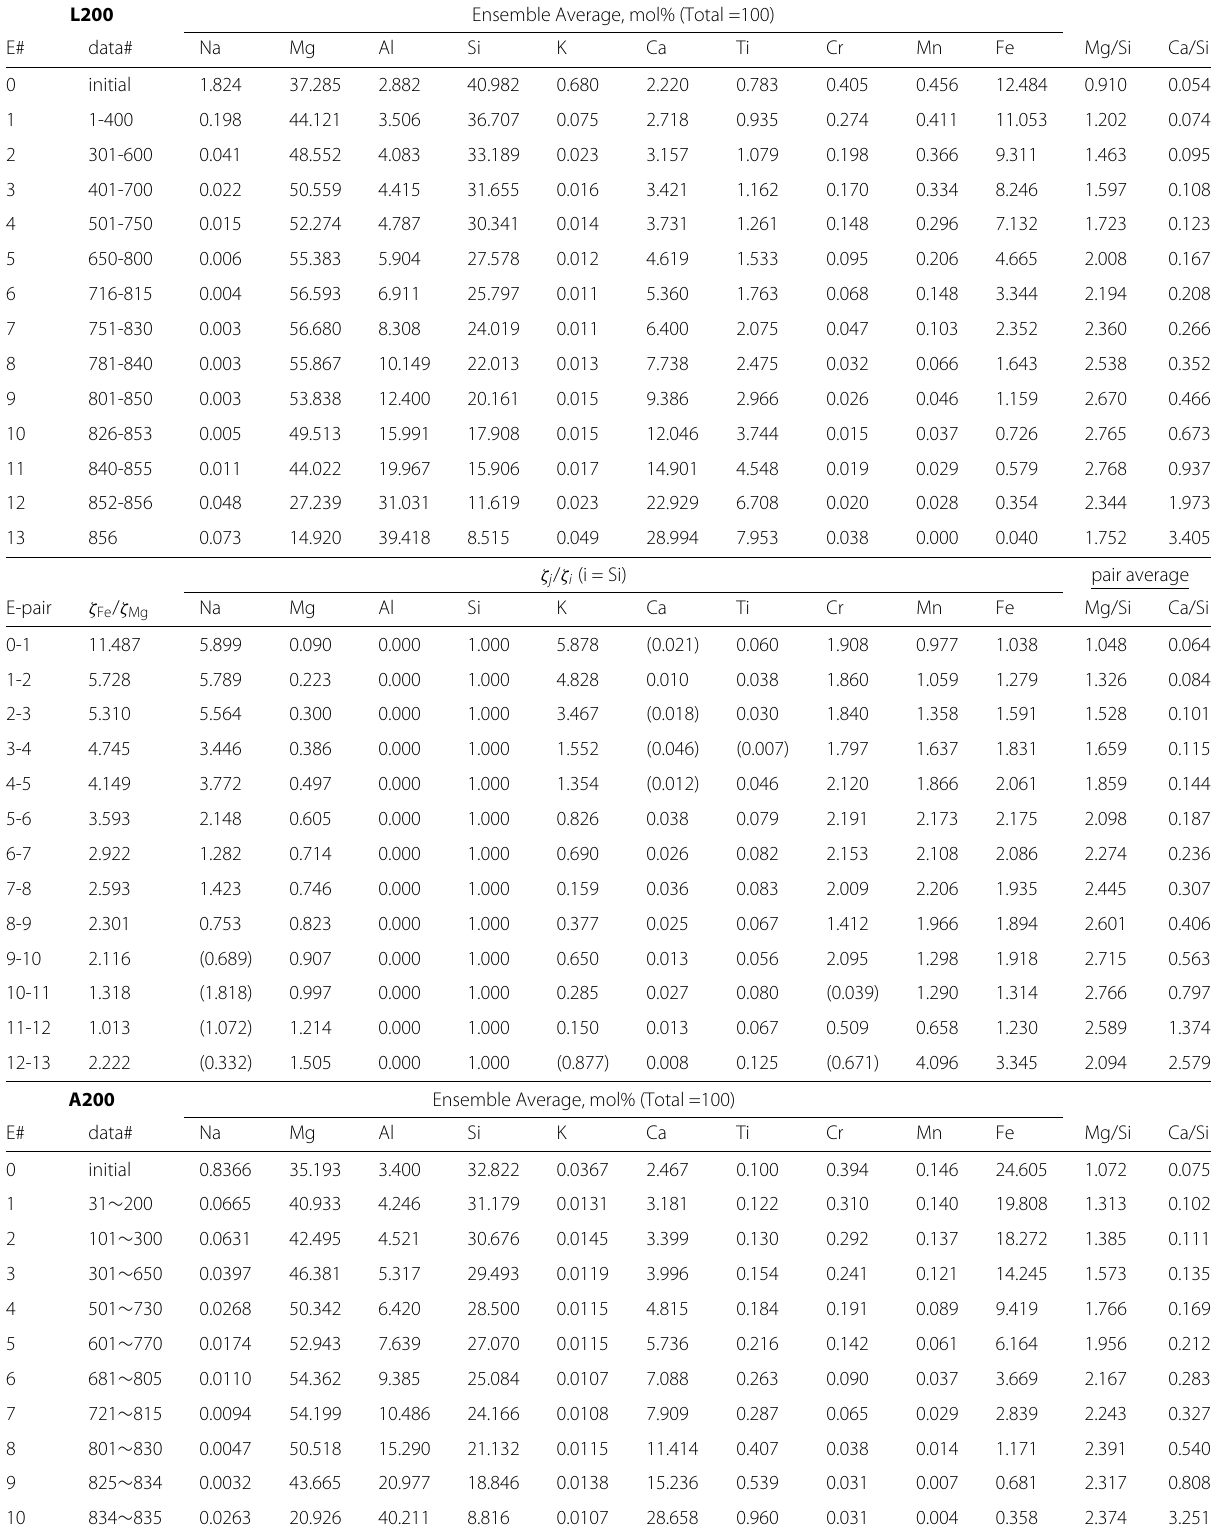
Table 4 Average chemical compositions of 13 ensembles (upper sections) and relative volatilities of elements (lower sections)